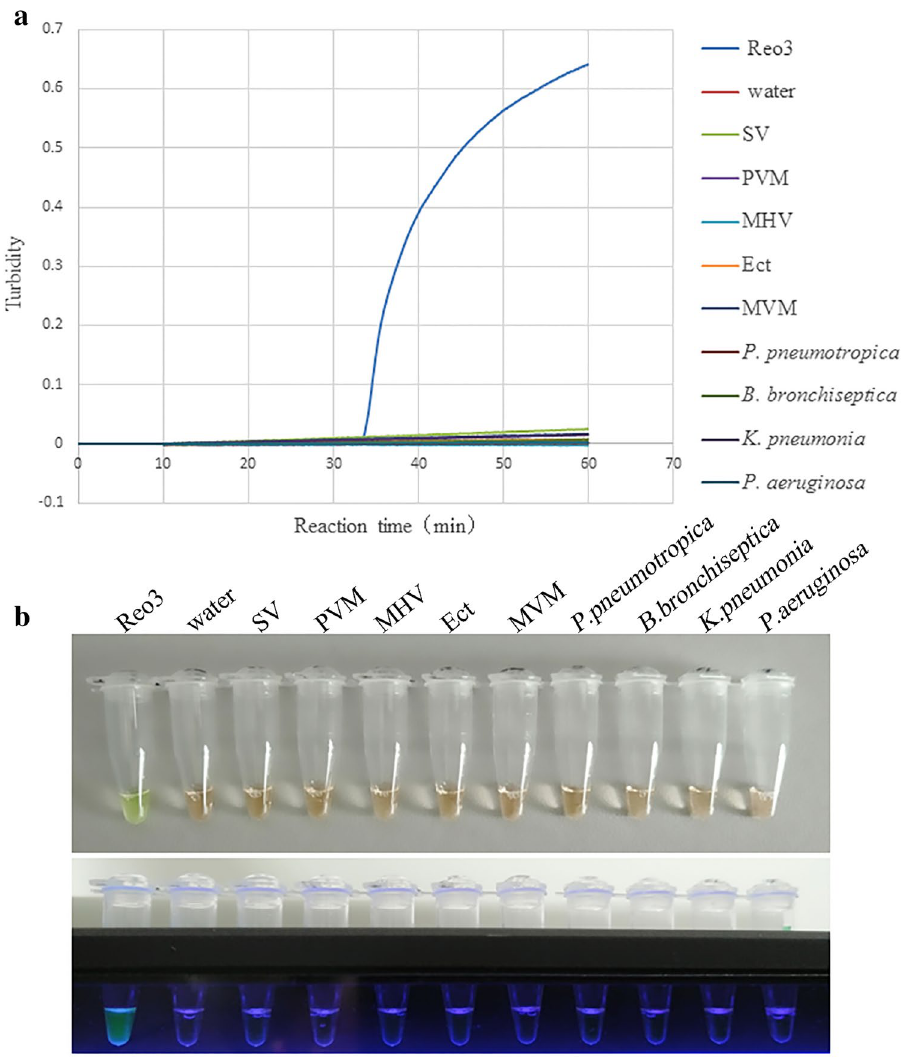
Figure 2. The specificity of the RT-LAMP assay based on the RS2 primers. ( a ) The turbidity curves generated by the Loopamp real-time turbidimeter, resulting in tests of the Reo-3, SV, PVM, MHV, Ect, MVM,